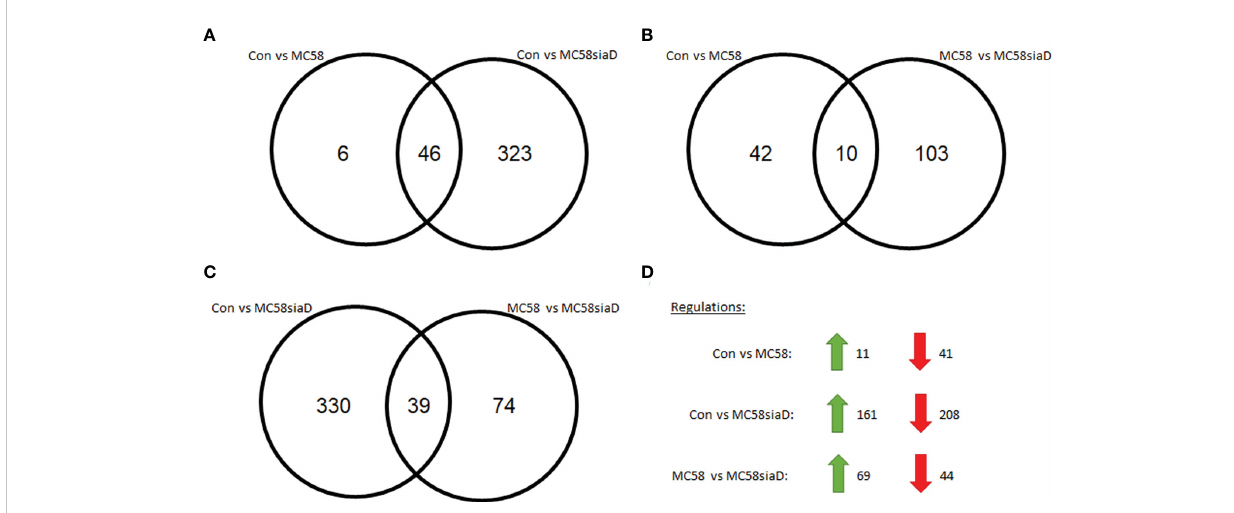
FIGURE 2 Schematic representation of the number of statistically relevant regulations identi fi ed in the phosphoproteomics analysis of HIBCPP infected with N. meningitidis wildtype strain and capsule-de fi cient mutant. Regulations were determined by comparing uninfected HIBCPP cells with cells infected with the N. meningitidis wildtype strain (Con vs MC58), uninfected HIBCPP cells with cells infected with the capsule-de fi cient mutant (Con vs MC58siaD), or cells infected with the N. meningitidis wildtype strain with cells infected with the capsule-de fi cient mutant (MC58 vs MC58siaD). Venn diagrams show overlaps between Con vs MC58 and Con vs MC58siaD (A) , between Con vs MC58 and MC58 vs MC58 siaD (B) , and Con vs MC58siaD and MC58 vs MC58siaD (C) . The distribution of regulations found for Con vs MC58, for Con vs MC58siaD, and for MC58 vs MC58siaD into up-regulated and down- regulated is shown in (D) . Only regulations having an adjusted p-value greater than or equal to 0.05 were